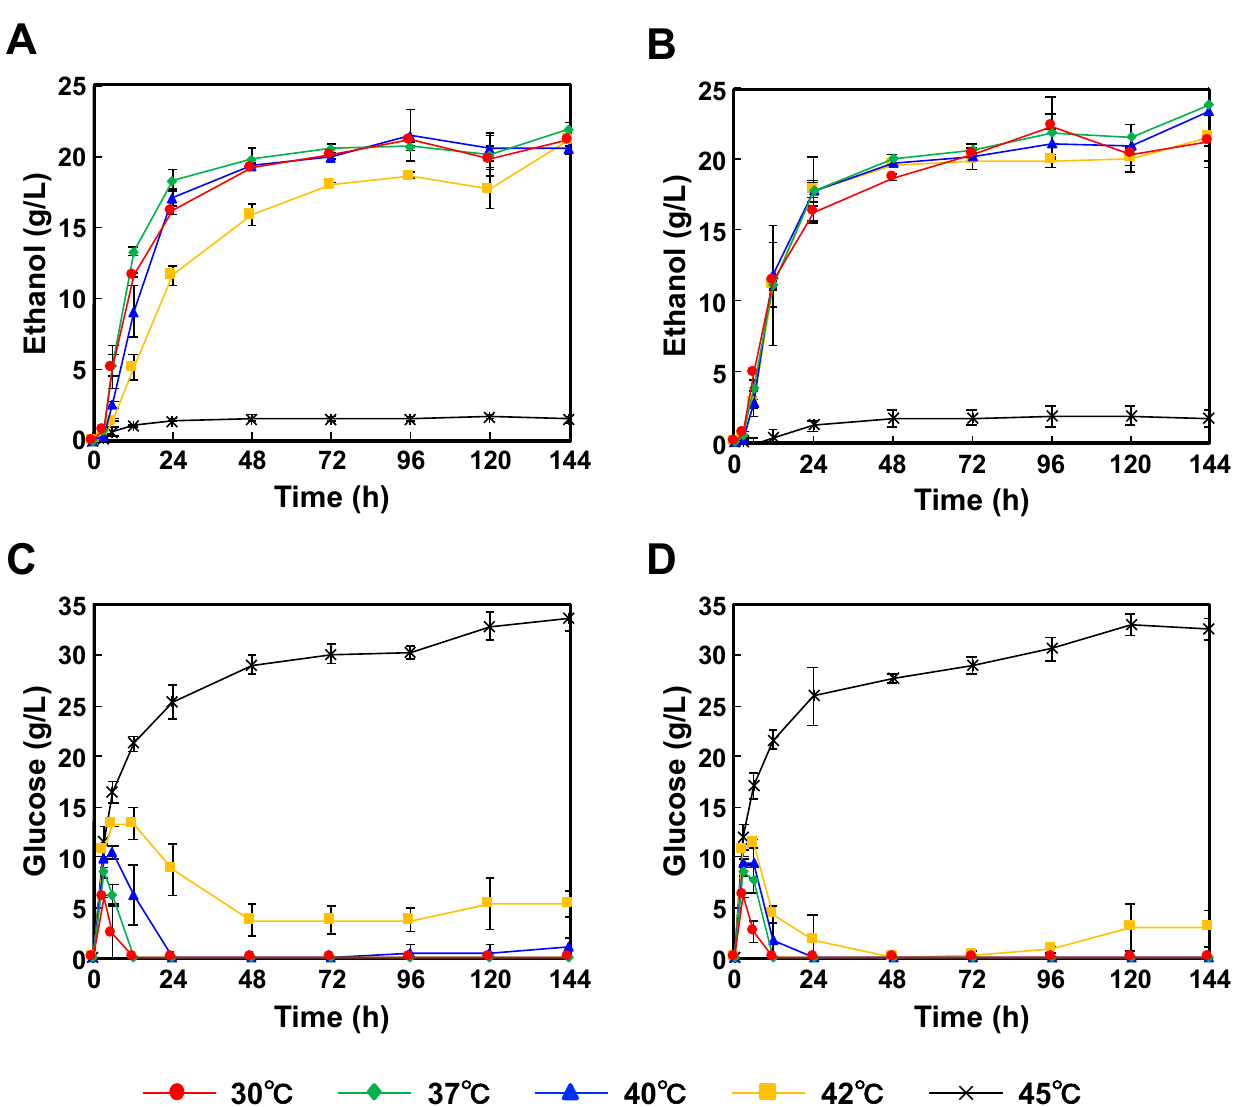
Figure 2. Comparison of the time-courses for P. kudriavzevii NBRC1279 and NBRC1664 during bioethanol production using Japanese cedar particles by SSF. ( A ) Ethanol production with strain NBRC1279; ( B ) Ethanol production with strain NBRC1664; ( C ) Glucose production with strain NBRC1279; ( D ) Glucose production with strain NBRC1664. Error bars indicate SE ( n = 3).